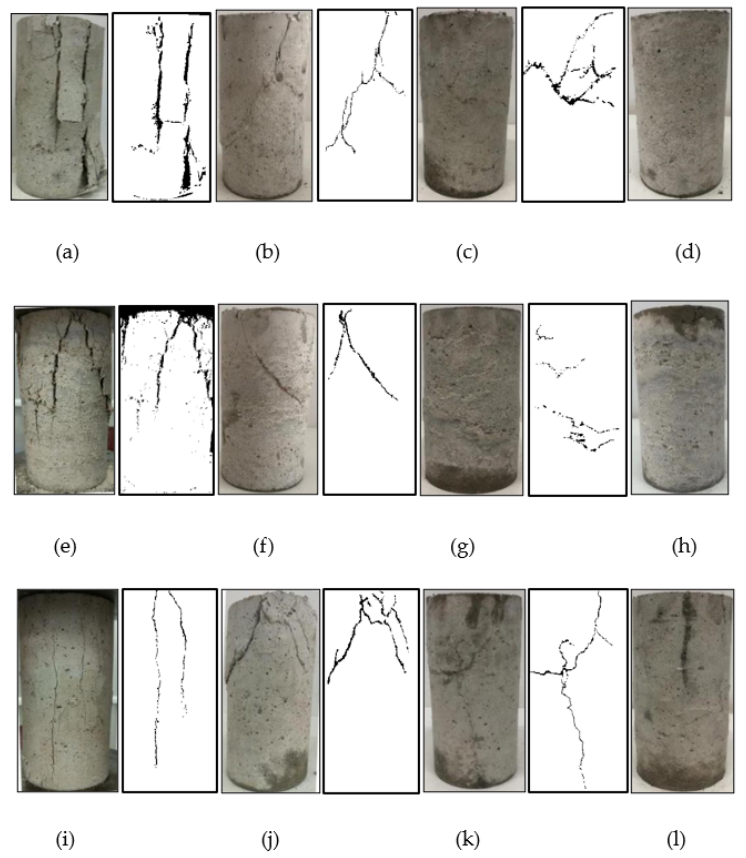
Figure 8. Destructive form of specimen. ( a ) PF-1-0-A, ( b ) PF-1-6-A, ( c ) PF-1-12-A, ( d ) PF-1-18-A, ( e ) PF-2-0-A, ( f ) PF-2-6-A, ( g ) PF-2-12-A, ( h ) PF-2-18-A, ( i ) PF-3-0-A, ( j ) PF-3-6-A, ( k ) PF-3-12-A, ( l ) PF-3-18-A.